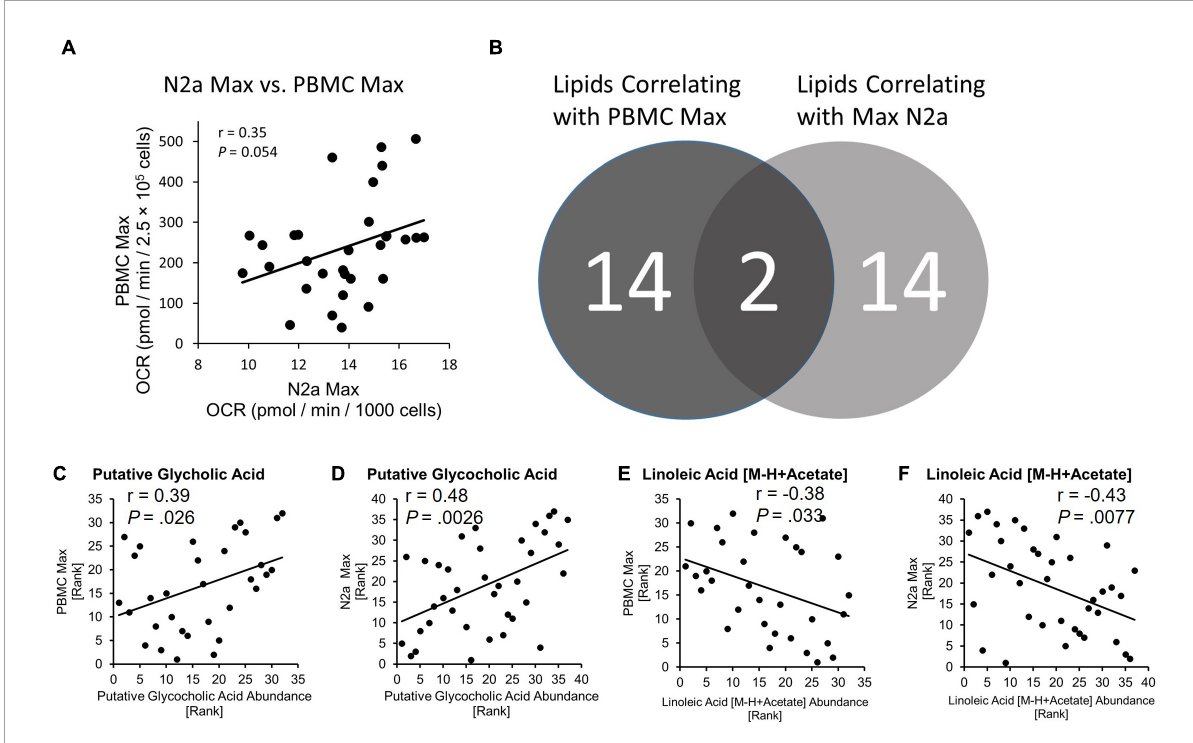
FIGURE3 Bioenergetic status of PBMCs is conferred to naïve N2a cells and lipids are related to bioenergetics. (A) PBMC Max and Max N2a positively correlate. (B) Number of lipids identified as correlating to PBMC Max and N2a Max. Exact P- values reported. (C,D) Spearman correlation of putative glycocholic acid to PBMC Max and N2a Max. (E,F) Spearman correlation of linoleic acid [M-H + Acetate] to PBMC Max and N2a